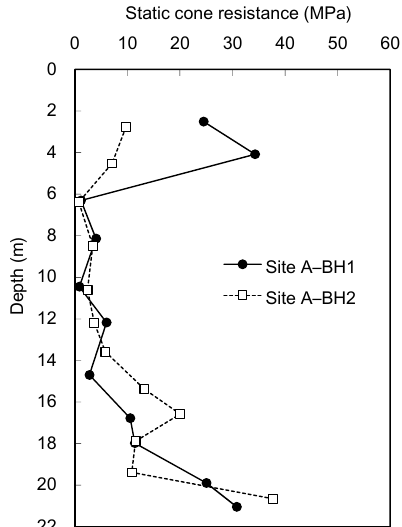
Figure 8. Profiles of average static cone resistances obtained from ICP.